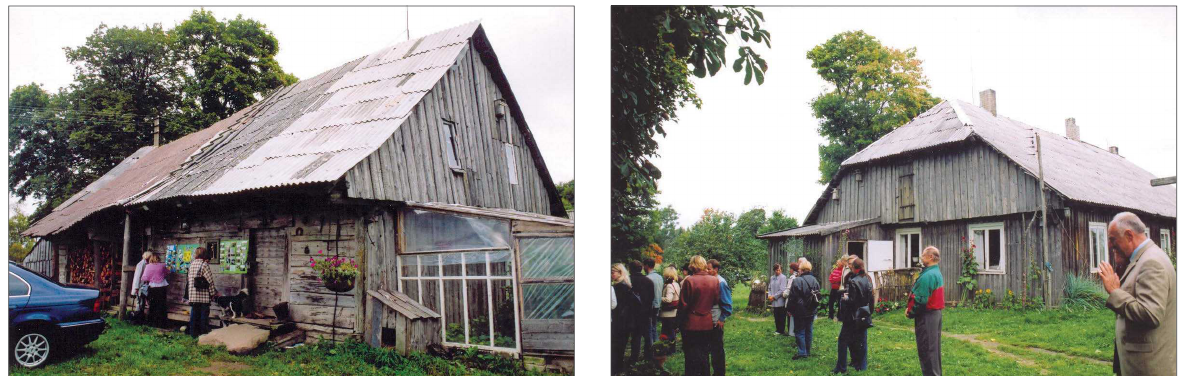
Fig 1. Condition of rural community buildings in Plungė region